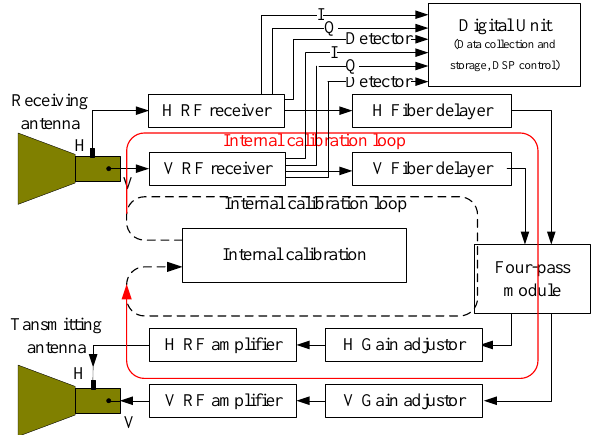
Figure 1. System block diagram of the GF-3 transponder.